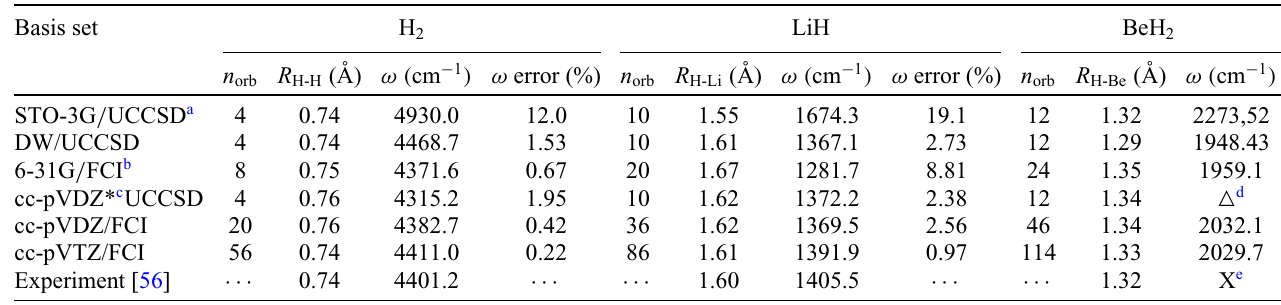
TABLE I. Structural property calculations for H 2 , LiH, and BeH 2 using different basis sets. The result from a given basis set is denoted with the abbreviation basis/method , e.g., the minimal Daubechies wavelet basis calculated by the method of quantum- computing UCCSD ansatz is represented by DW/UCCSD. The total number of spin orbitals used in the calculation is denoted as n orb . The equilibrium bond lengths are obtained from the minimum energy positions and the vibrational frequencies are obtained from the curvatures near the optimized (minimum-energy) bond lengths of the potential energy curves in Figs. 1(a), 1(c), and 1(e), respectively. Basis set H 2 LiH